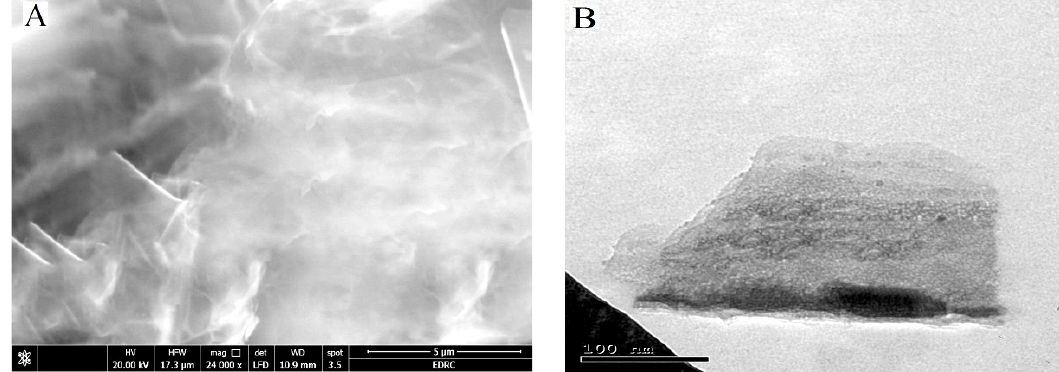
Figure 2. ( A ) SEM and ( B ) TEM images of the synthesized GO nanosheets.